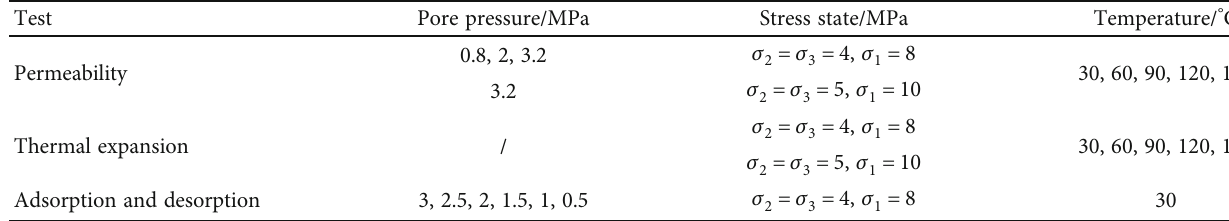
Figure 1: High temperature multifunctional triaxial test system. Table 1: Test